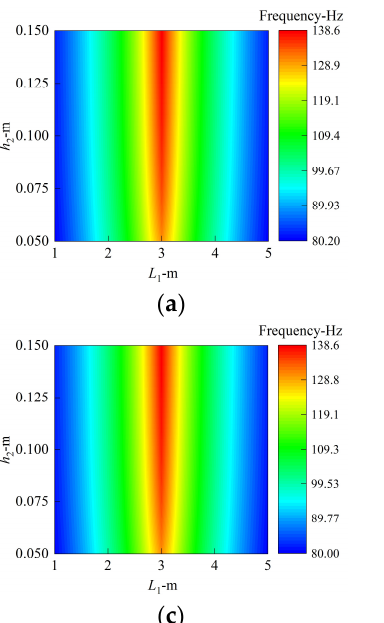
( d ) Figure 7. The first mode shapes with L 1 = 5 m and h 2 = 0.15 m. ( a ) Clamped boundary. ( b ) Simply supported boundary. ( c ) Shear–diaphragm boundary. ( d ) Free boundary. From Figure 6, no matter what the boundary conditions, the natural frequency of the structure will increase with the thickness of the annular plate. This may be explained by the fact that the growth in the thickness of the annular plate contributes to the improve- ment of the overall rigidity of the structure in the form of reinforcing ribs, which can in- crease the associated frequencies. Similarly, changes in the position of the annular plate will also have an important impact on the overall rigidity of the structure. For all the boundary conditions herein, when the second annular plate is located in the middle ( L 1 = 3 m), the frequency of the structure is the largest, with an increment of over 72% compared to those of L 1 = 1 m or 5 m. When the annular plate moves to both ends, the frequency result decreases. In addition, one phenomenon can be easily observed that the value and trend of the first frequencies are similar for those in Figure 6a–d; the reason may be that the assembled structure owes strong structural stiffness to the coupling relationships be- tween the substructures for one thing; for another, the mode shapes which are presented in Figure 6 and correspond to the first structural frequency are located in the cylindrical shell, of which both ends are combined to other substructures, resulting in the first struc- tural frequency being insensitive to boundaries imposed on the conical shell. Next, we study the comprehensive influence of the thickness and inner diameter of the three annular plates on the vibration characteristics of the structure in Figure 8. The